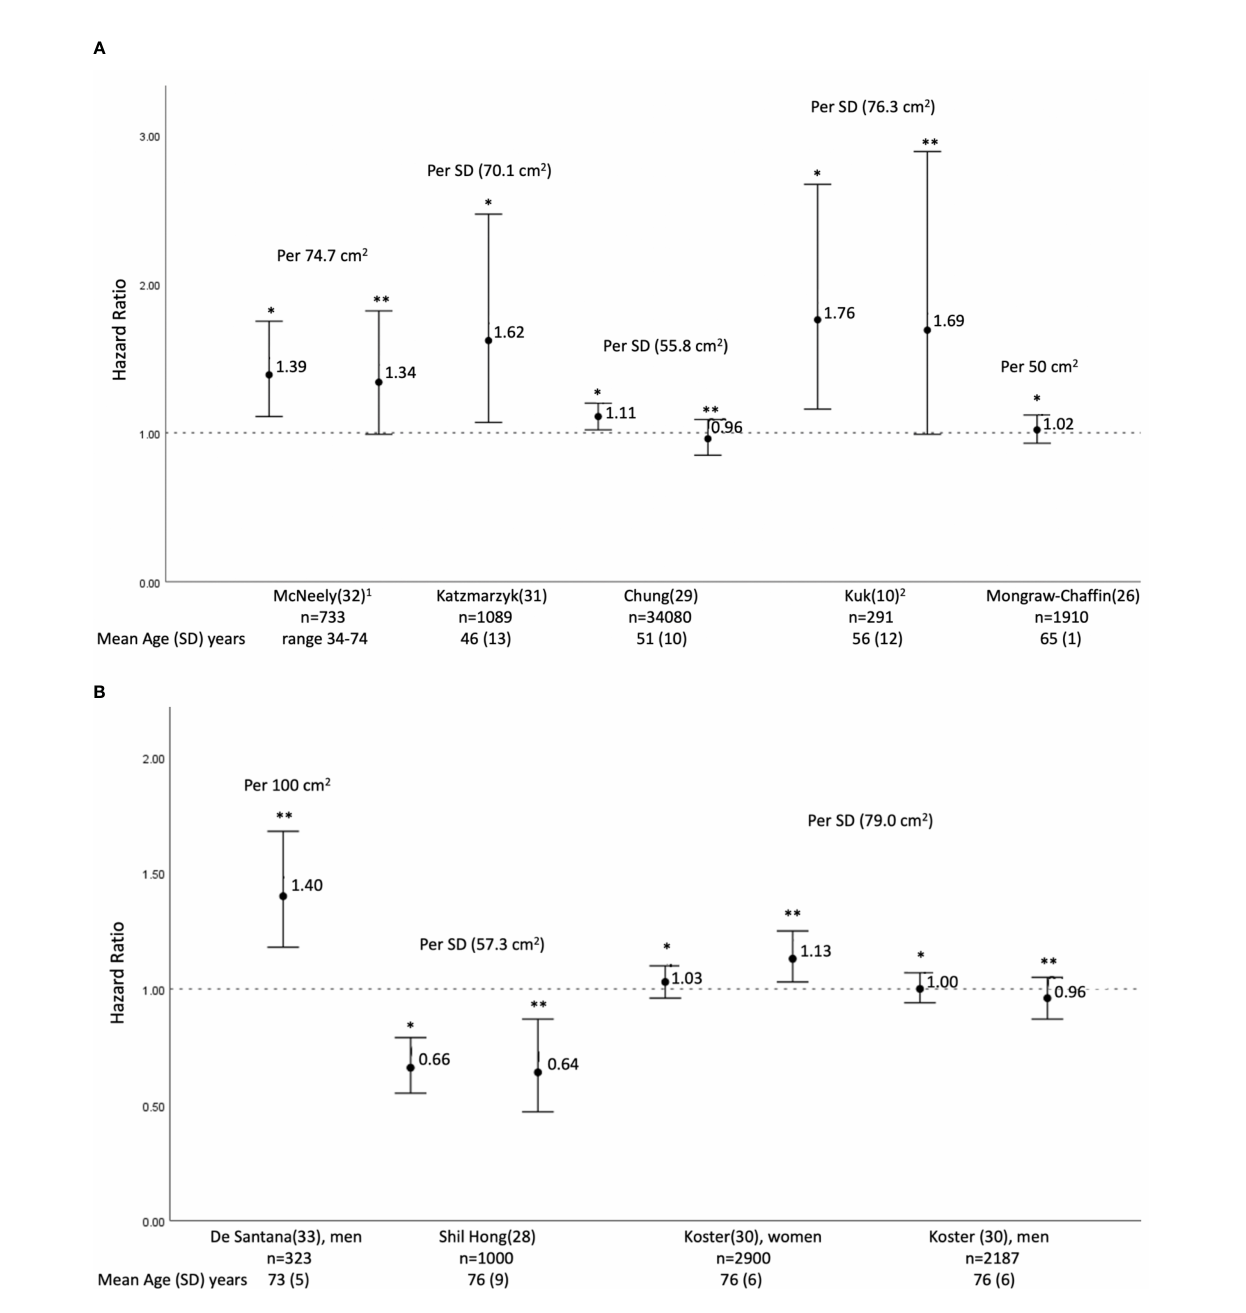
FIGURE 2 | Hazard Ratios (HRs) and 95% con fi dence interval of all-cause mortality per increase in abdominal visceral adipose area (cm 2 ); the increase being de fi ned individual studies as the standard deviation or as a fi xed number. (A) studies with participants ’ mean age of 65 years or less; (B) studies with participants ’ mean age above 65 years. 1 Result reported as hazard ration (HR) per incremental increase in abdominal visceral adipose tissue equivalent to the magnitude of the interquartile range (IQR), 25 th percentile 48.2 cm 2 and the 75 th percentile 122.9 cm 2 (personal communication with author). 2 Mortality risk expressed as Odds ration (OR). *Unadjusted or adjustment does not include BMI and glycemic parameters; McNeely et al (32) HR adjusted for sex and smoking. Katzmarzyk et al (31) ) HR adjusted for age, sex, smoking, alcohol consumption, exam year, subcutaneous tissue area, physical activity and excluding patients with a history of stroke, heart disease and cancer at baseline. Chung et al. (29) unadjusted HR. Koster et al (30) HR adjusted for age, education, smoking, physical activity , and alcohol. ** Adjusted includes BMI and/or glycemic parameters; McNeely et al. (32) HR adjusted for sex, smoking and BMI. Chung et al. (29) HR adjusted for age, sex, diabetes, hypertension, fatty liver. Subcutaneous tissue area, and signi fi cant alcohol consumption. Kuk et al. (10). OR adjusted for age, follow-up time, abdominal subcutaneous fat and liver fat. De Santana et al. (33) OR adjusted for age, low level of physical activity, recurrent falls, diabetes mellitus, hypertension, previous cardiovascular event, serum phosphorus, serum calcium, albumin and total hip bone mineral density T-score. Shil Hong et al (28) HR adjusted for age, sex, smoking, alcohol consumption, physical activity, and total fat mass. Koster et al. (30) HR adjusted for age, education, smoking, physical activity, alcohol, body mass index, type II diabetes, and coronary heart